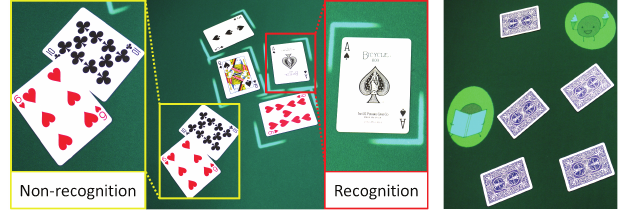
Figure 6. Light frame effect (left) and spotlight effect